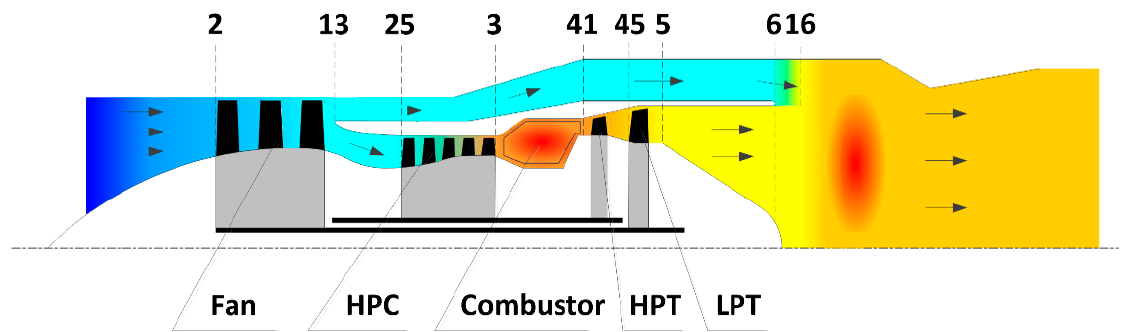
Figure 1. The configuration of the turbofan engine.